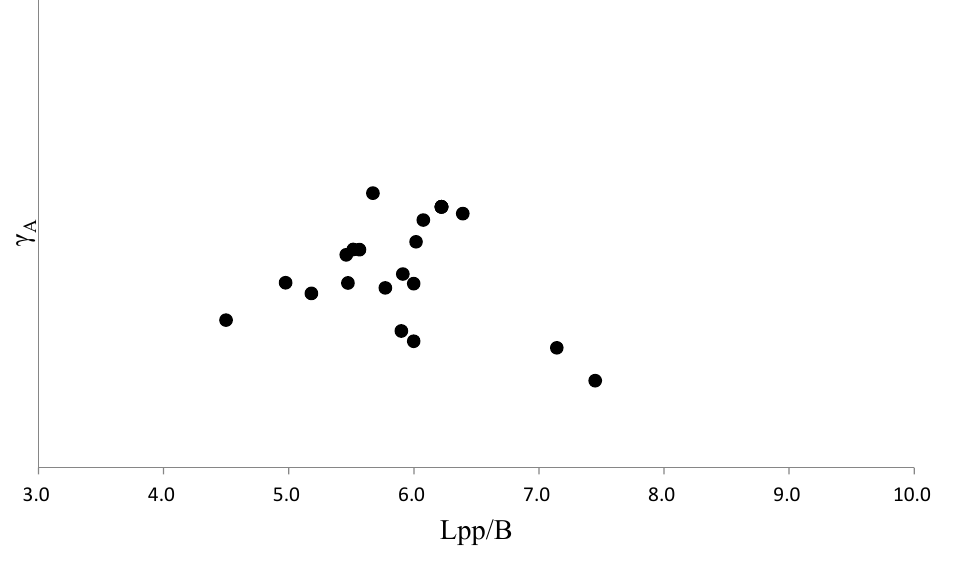
Figure 12. γ A and L pp /B of types of ships. Figure 12. (cid:2011) (cid:3002) and L pp /B of types of ships. Table 6. List of the calculation conditions of the objective ships. Table 6. List of the calculation conditions of the objective ships.